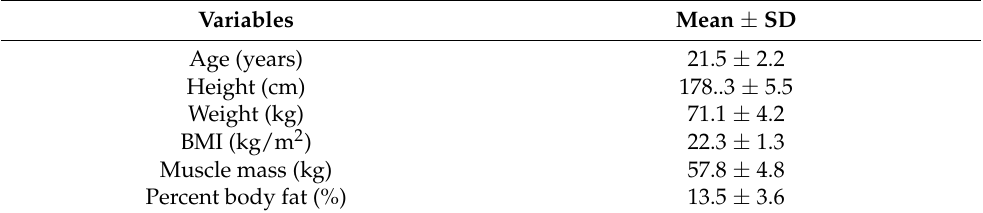
Table 1. Characteristics of